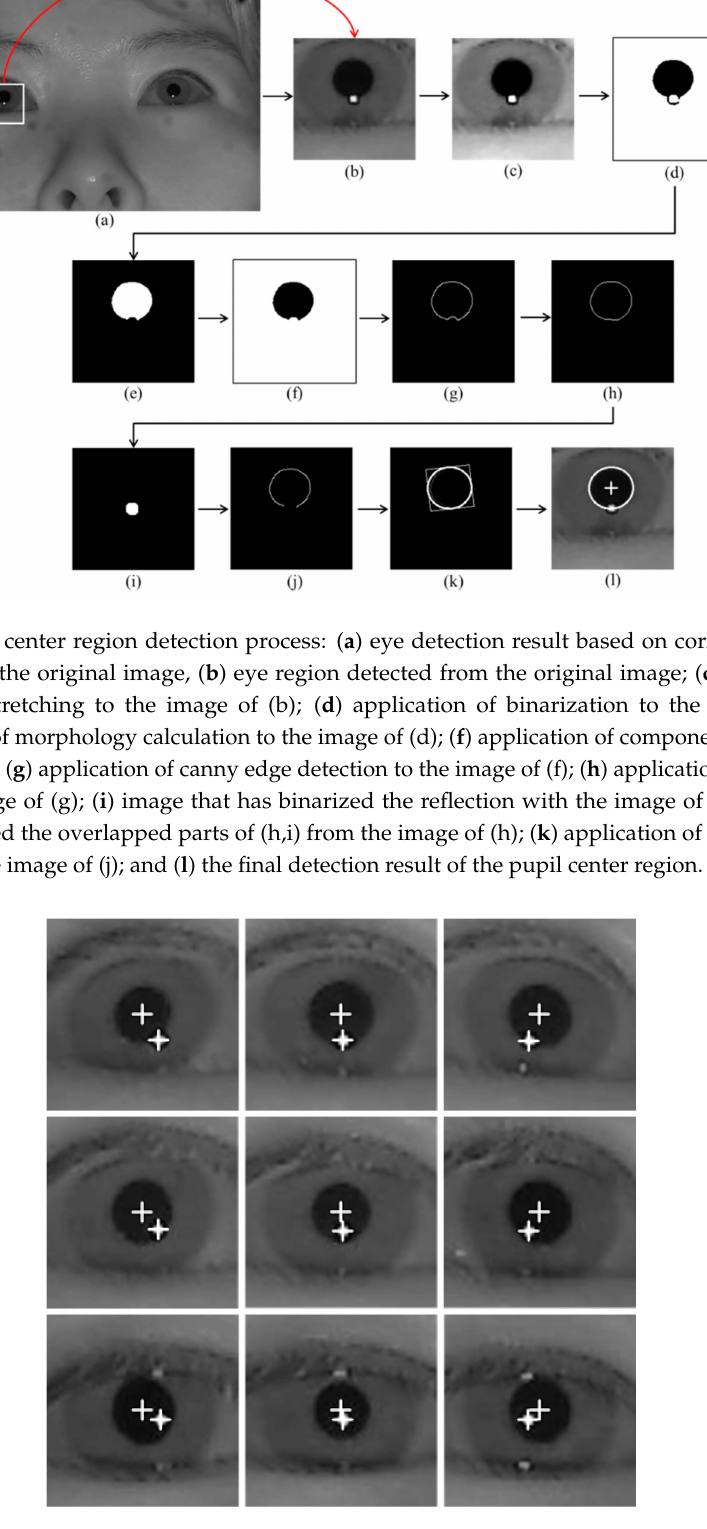
Figure 3. Images of user’s eye region when gazing at nine calibration points on the